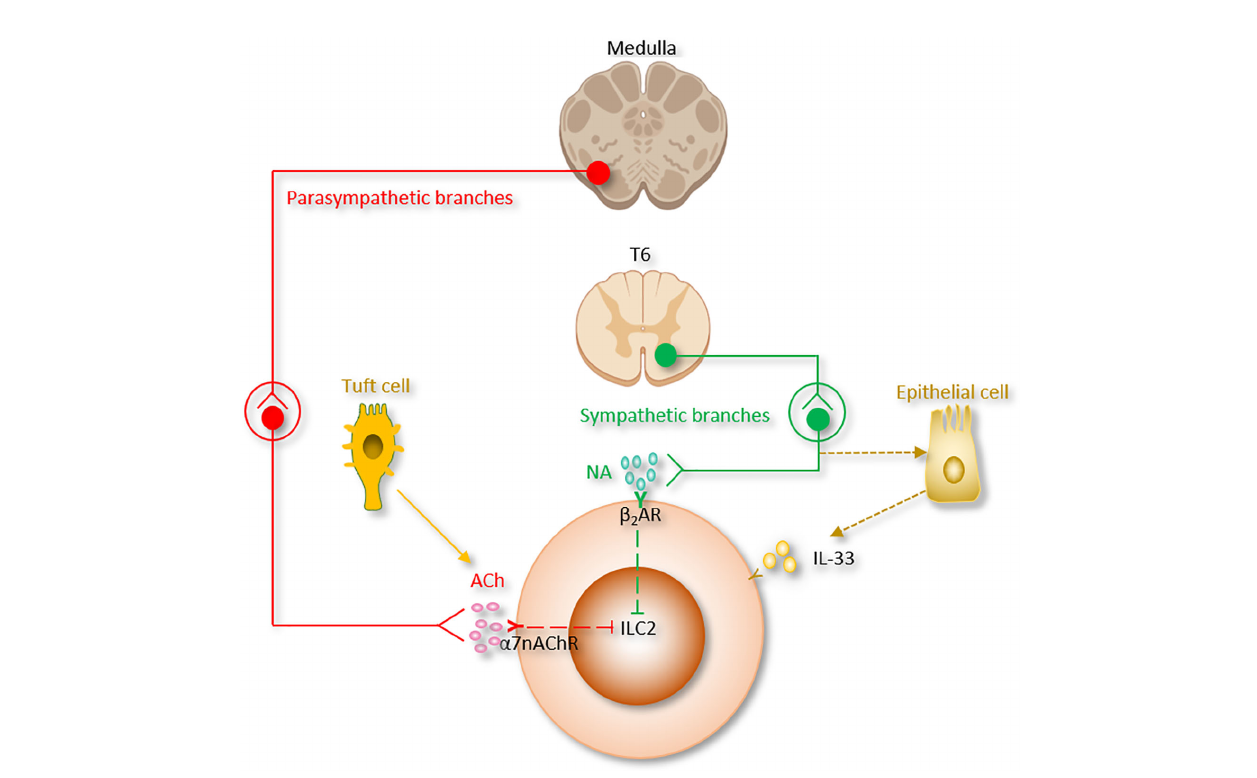
FIGURE 2 | The autonomic nervous system regulation of ILC2 function. Ach, Acetylcholine; a 7nAChR, a 7 nicotinic acetylcholine receptor; b 2 AR, b 2 -adrenergic receptor; NA,